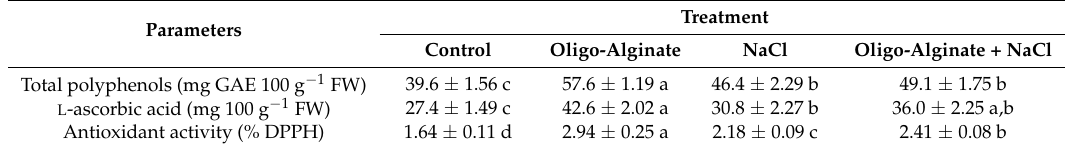
Effect of oligo-alginate and NaCl on content of total polyphenols, L -ascorbic acid and antioxidant activity (2,2-diphenyl-1-picrylhydrazyl (DPPH) free radical reduction) of Eucomis autumnalis . Means ( ± standard errors) followed by the same small letter in the same row did not differ by Tukey Test ( p ≤